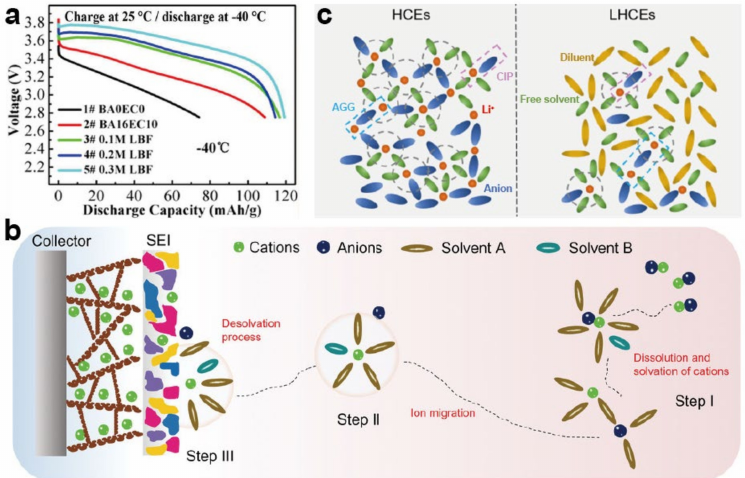
Figure 7. ( a ) Charge and discharge curves of NCM811 cells with different electrolytes at − 40 ◦ C [16]. Reproduced with permission from Chemical engineering journal; published by Elsevier, 2021; ( b ) illustration of the solvation process during operation [127]. Reproduced with permission from Chinese Journal of Chemistry; published by Wiley, 2022; ( c ) schematic of the solvation structures of HCEs and LHCEs [128]. Reproduced with permission from ACS Applied Materials & Interfaces; published by American Chemical Society,